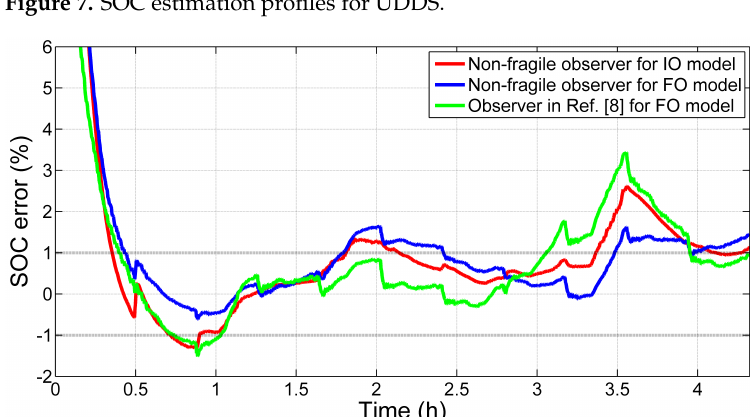
Figure 8. SOC estimation error profiles for